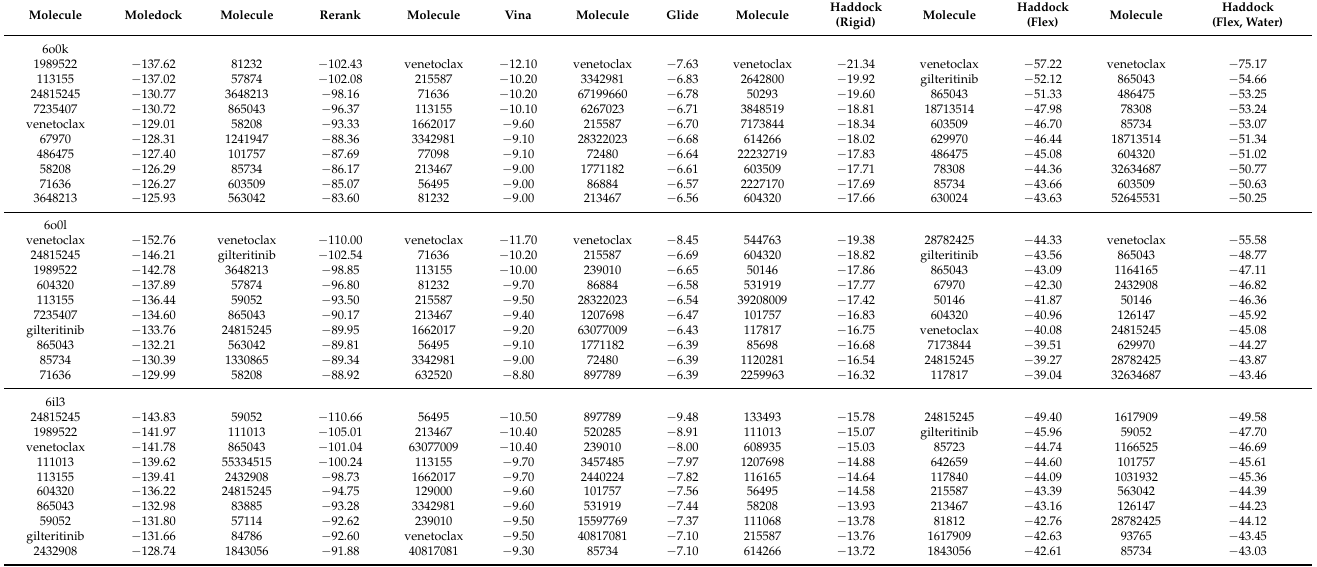
Table 1. The top 10 hit molecules from the seven docking scores (Moledock, Rerank, Vina, Glide, Haddock(rigid), Haddock(flex) and Haddock(flex, water)) ranked according to their binding. The molecules from the traditional herbs are named, according to the CAS number that was used to extract them from the NIST database. The names of all of the molecules are added to Table S1 of the Supplementary